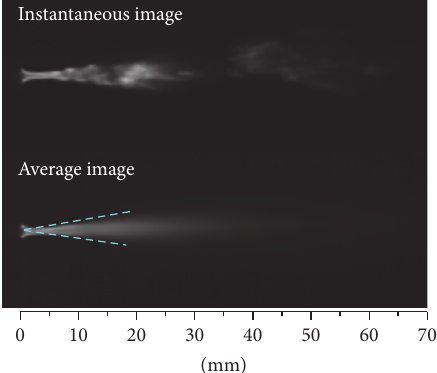
Figure 3: The instantaneous and average images of flame (condition 33).